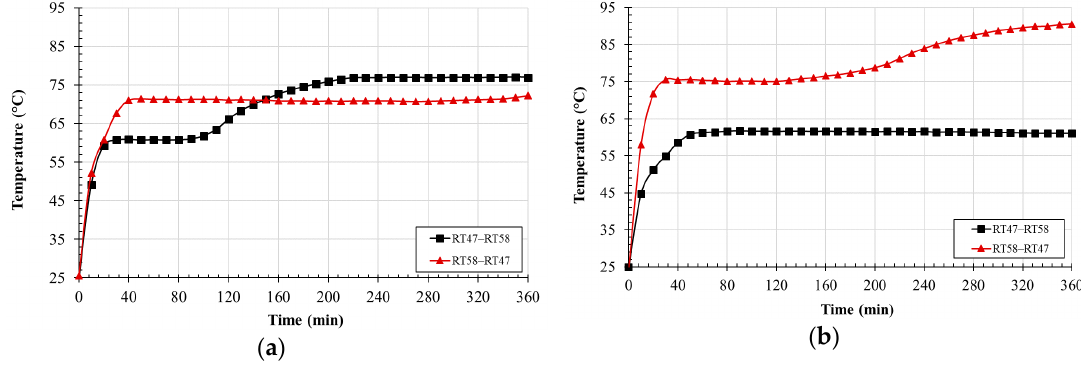
Figure 14. Heat sink surface temperature of heat sink C for different PCMs at power ratings ( a ) 1.5 W and ( b ) 2.0 W.